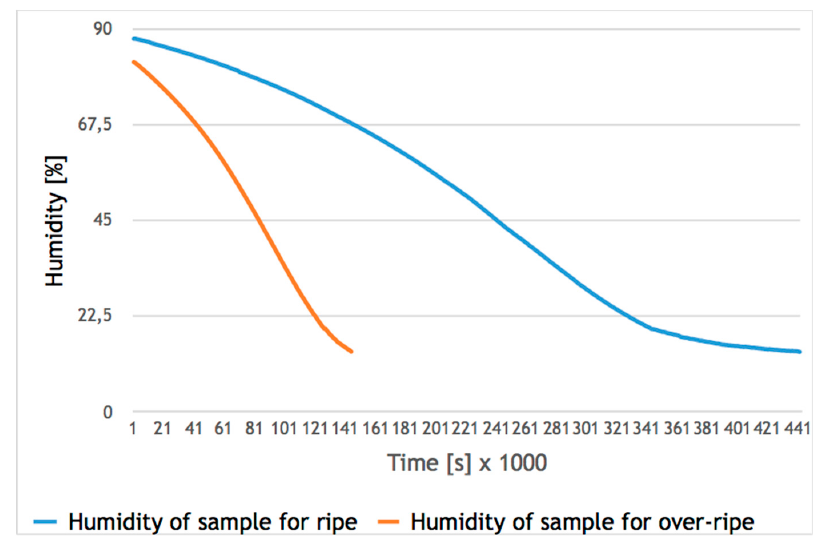
Figure 1. Convection drying curve for trials with ripe and over-ripe strawberry fruits in relation to the change in humidity over time.